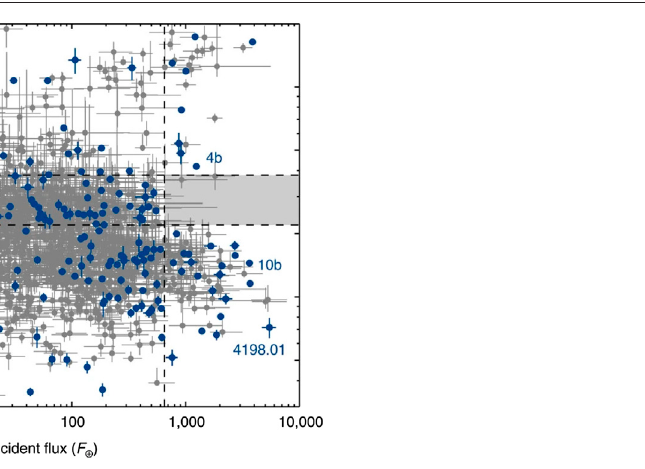
FIGURE 7 | Exoplanet radius as a function of incident fl ux for a large sample of Kepler Objects of Interest (gray fi lled circles). The blue fi lled circles are 157 of those planetswhosehostshaveseismicmeasurements.Thekeypointisthehighlevelofprecisiononboththeradiusandincident fl uxoftheseismicsample( < 10%).Thegray shadedregionisthehotsuperEarthdesert,whichreceivesatleast650timestheamountofincident fl uxasEarthandgetsclearlydelineatedduetotheseismicmeasurements.The inset shows a larger non-seismic sample. The four terrestrial planets are shown for reference. Figure from Lundkvist et al. (Lundkvist et al.,